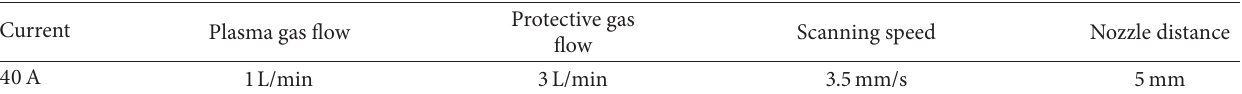
Table 2: Plasma remelting